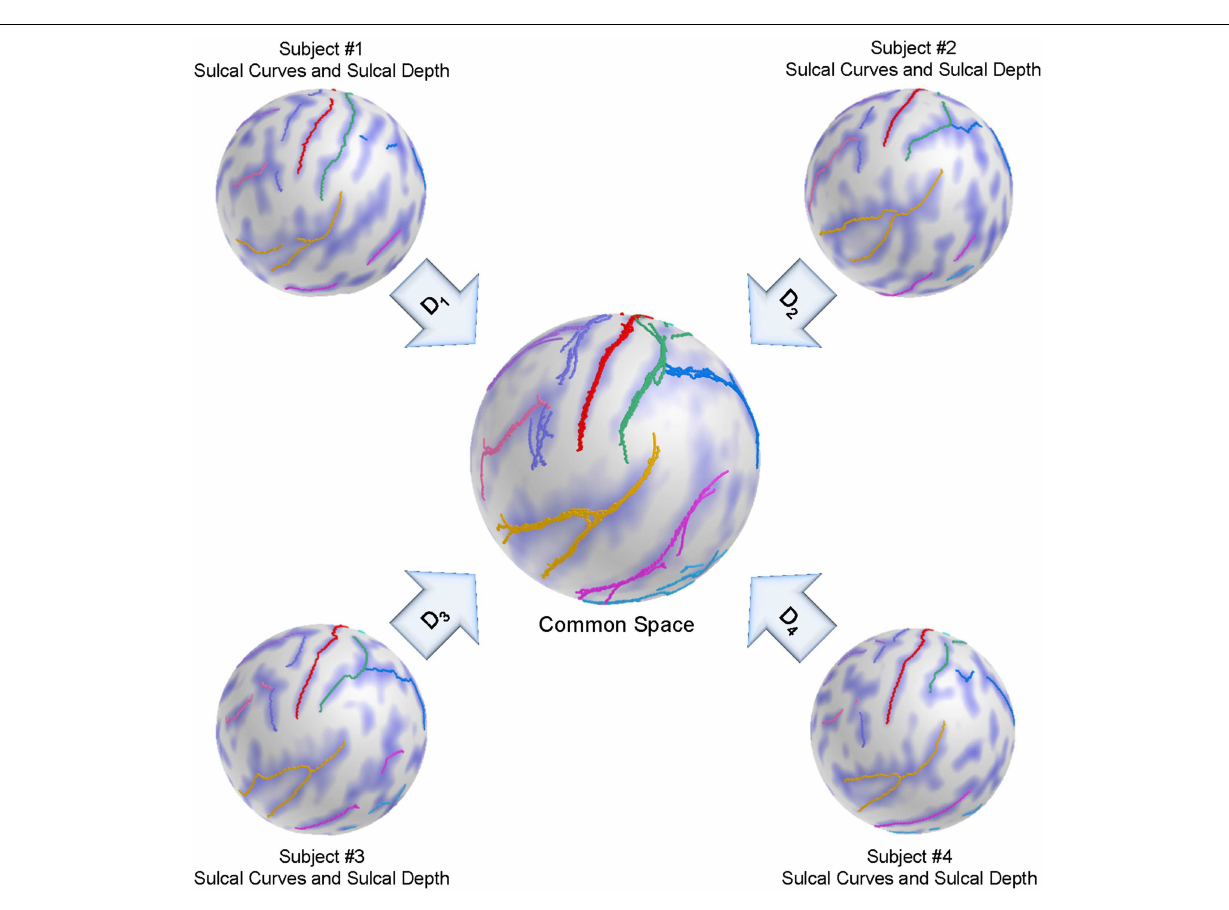
onto the sphere based on the pair-wise correspondence. The group-wise correspondence is then iteratively updated across a population via entropy